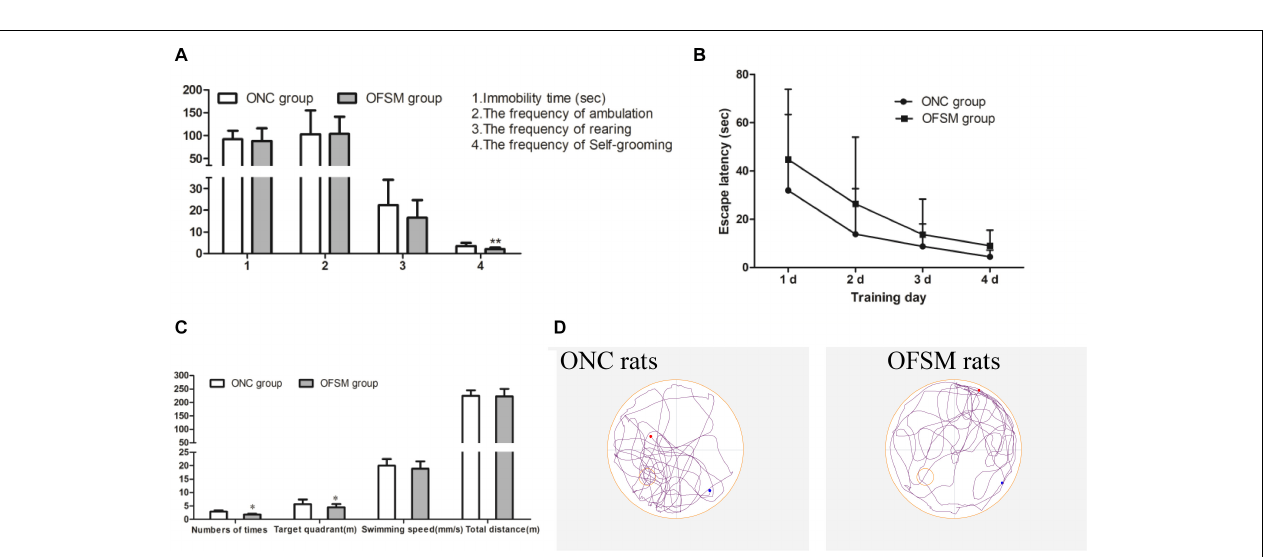
FIGURE 4 | Fear stress in pregnant rats may affect the behavior of their offspring. (A) Immobility times in the TST and the frequency of ambulation, rearing, and self-grooming in the OFT. (B) Escape latency during the four training days in the MWM. (C) Swimming speeds and distances during the probe test in the MWM. (D) Representative MWM-generated swimming tracing pattern for offspring from the normal control group (ONC) and for offspring from the fear stress model (OFSM) group in the probe tests. TST, Tail Suspension Test; OFT, Open Field Test; MWM, Morris Water Maze. Values are expressed as means ± standard deviations. ONC group ( n = 19), OFSM group ( n = 18). * P < 0.05, ** P < 0.01 versus ONC group.